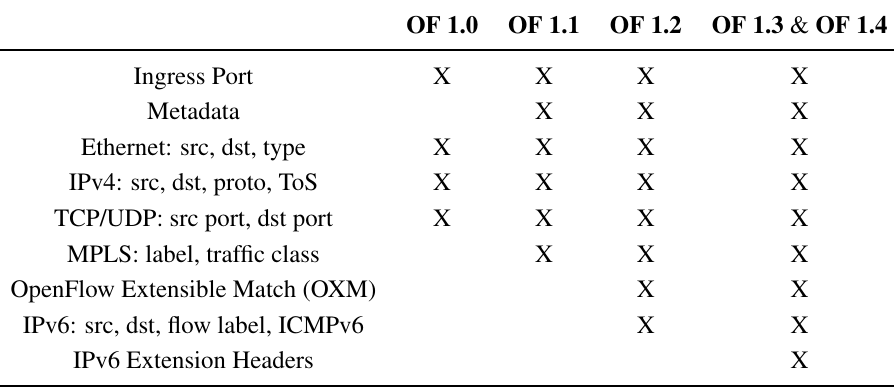
Table 2. OpenFlow (OF) match